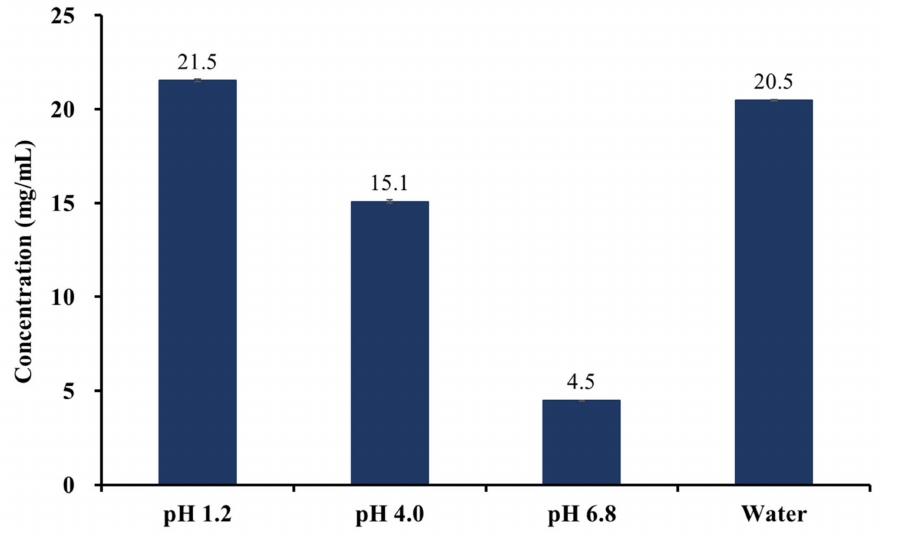
Figure 6. The Solubility of JLS in water, pH 1.2, pH 4.0, pH 6.8 buffer ( n = 3).